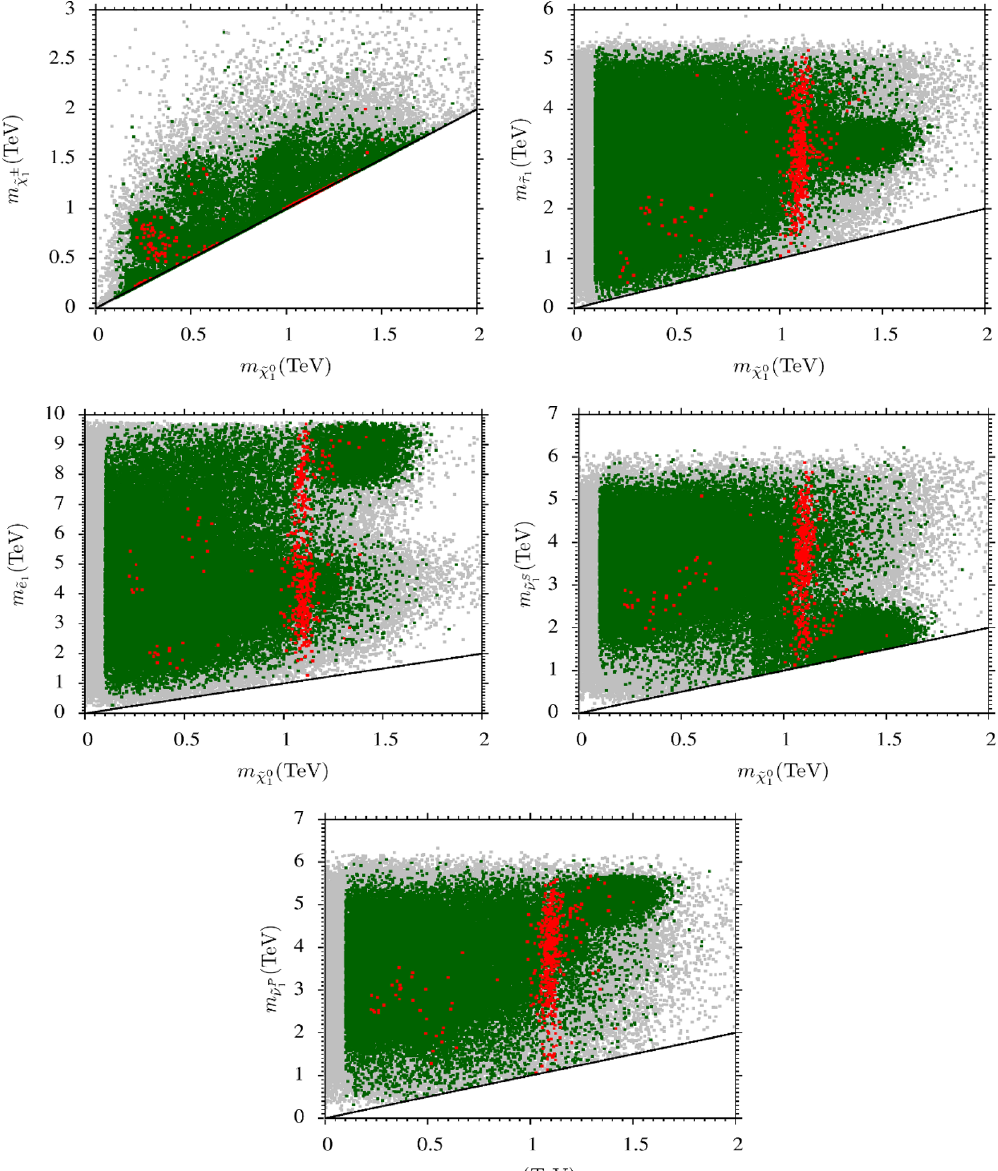
Figure 2 . Plots in the m color coding is the same as in figure 1. The diagonal lines represent the solutions with degenerate masses of the particles